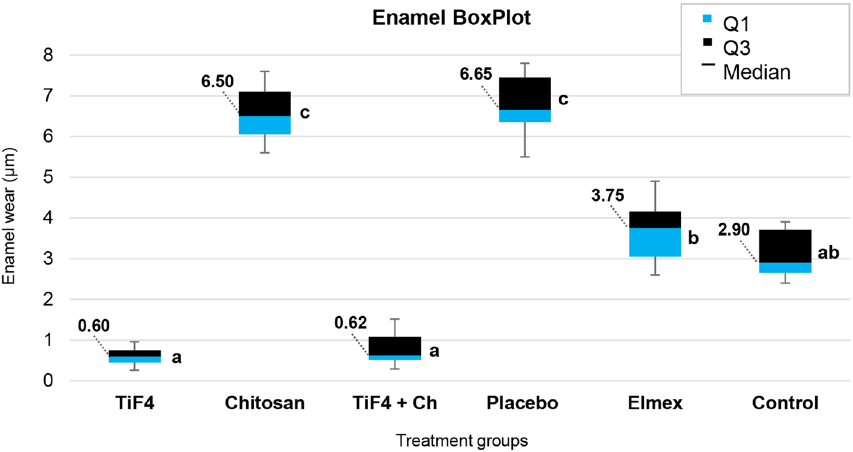
Figure 1. Box Plot of enamel wear (µm) after the experimental protocol according to each treatment group [median (interquartile range-II)]. Q1 quartile1, Q3 quartile 3. Kruskal–Wallis/Dunn test (p < 0.0001). Different letters show significant differences among the